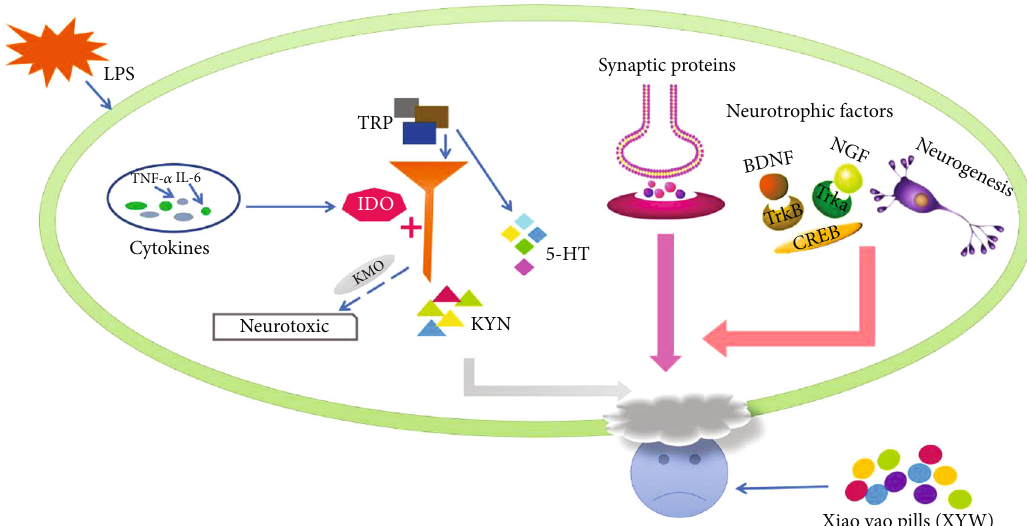
Figure 7: Graphical abstract. Xiaoyao Pills (XYW) ameliorated the depression-like behavior, decreased the levels of in fl ammatory indicators, increased those of neurotrophic factors and synaptic proteins, and increased hippocampal e ff ect of Xiaoyao Pills on the in fl ammatory response of hip- pocampal neurons in vitro .